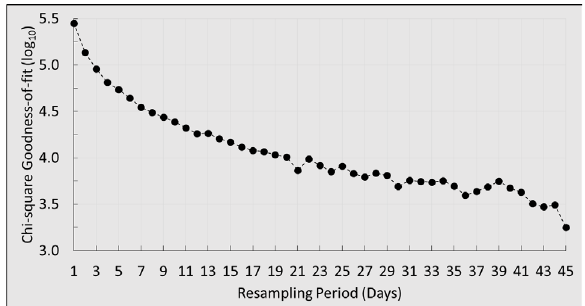
Figure 13. Chi-square goodness-of-fit regarding resampling period in modelling of precipitations and velocities for target point 6 (Figure 3).